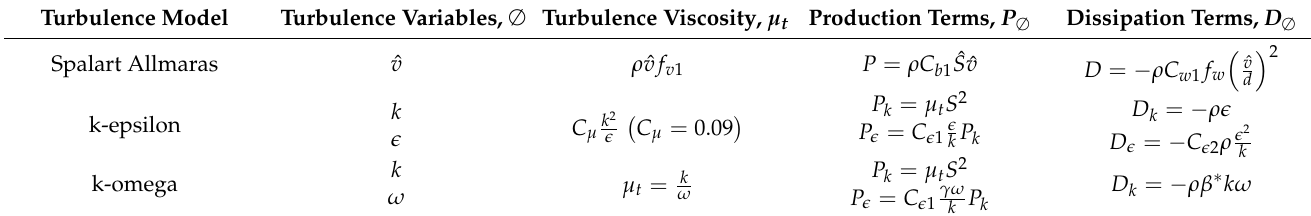
Table 1. Expressions for turbulence terms for selected turbulence models. Turbulence